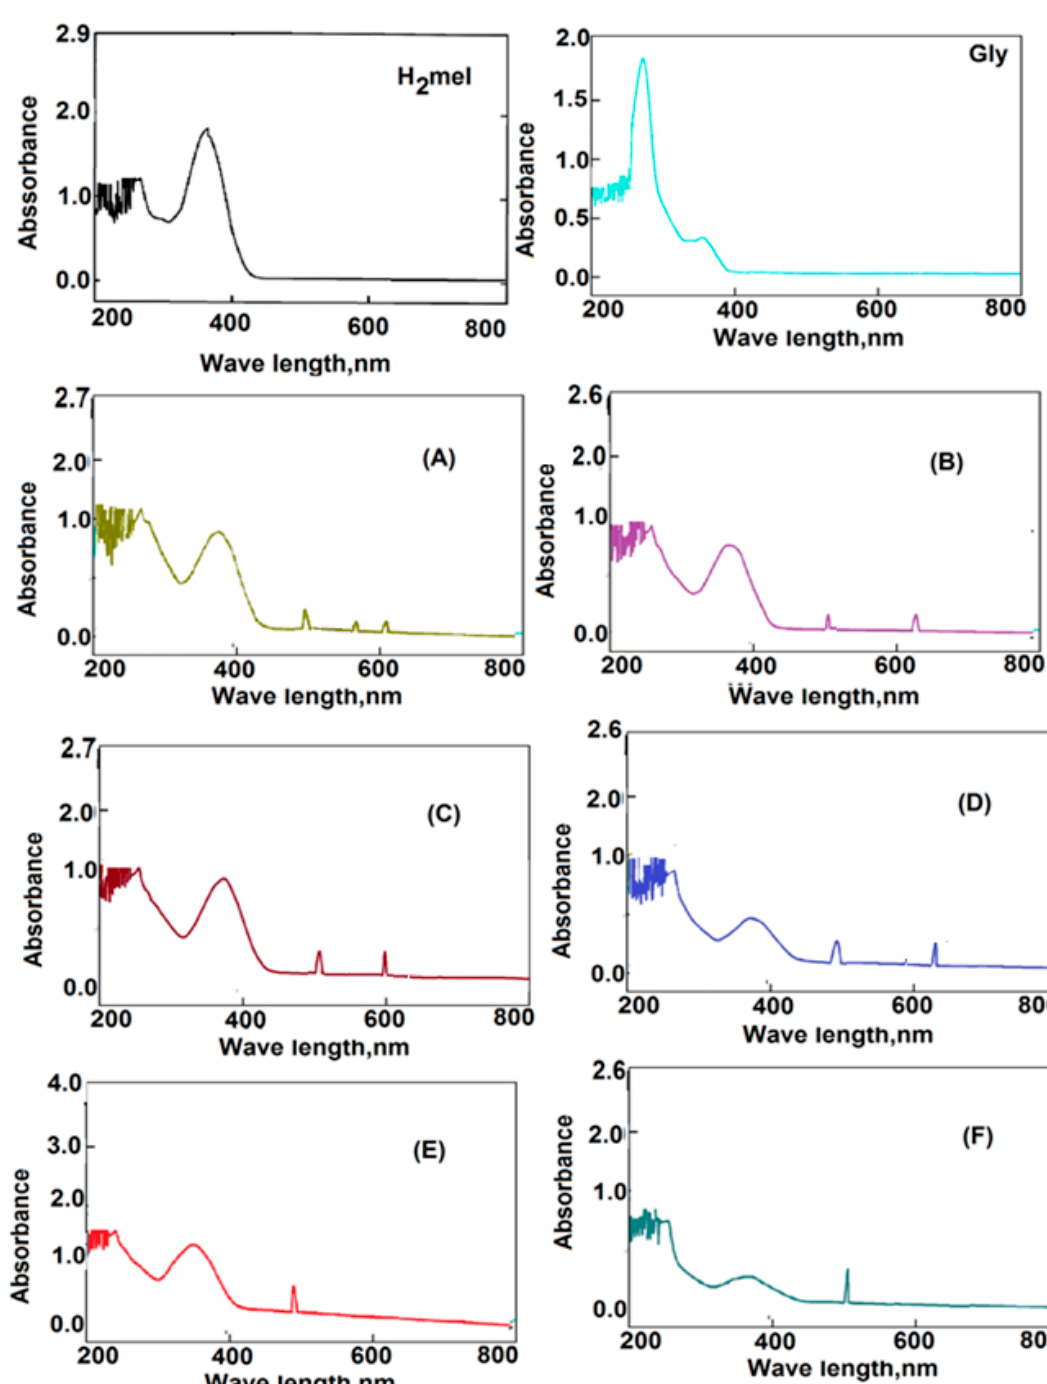
Figure 1. Electronic absorption spectra for H 2 mel, Gly and their metal complexes. Where, ( A ) = Mn(II) complex, ( B ) = Co(II) complex, ( C ) = Ni(II) complex, ( D ) = Cu(II) complex, ( E ) = Zn(II) complex and ( F ) = Zr(IV) complex.